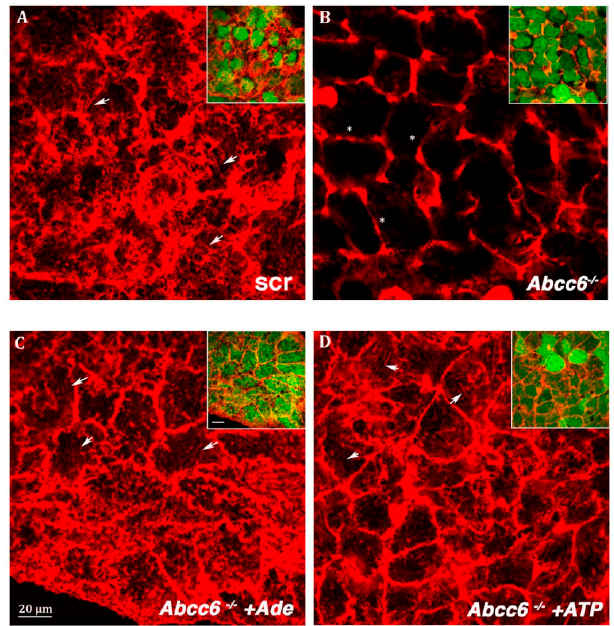
Figure 6. Representative confocal image of ( A )—scrambled HepG2 cells; ( B )—Abcc6-shRNA.HepG2 cells; ( C )—Abcc6-shRNA HepG2 cells treated with 500 µM ATP; ( D )—Abcc6-shRNA HepG2 cells treated with 100 µM adenosine. F-actin was stained with Texas Red-phalloidin. In the insets superposition of cytoskeleton (red) and EGFP (green) to monitor the infection efficiency. The scale bar in the inserts is 40 µm [32].